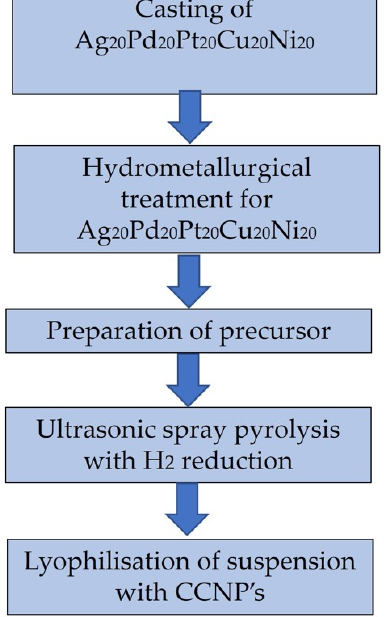
Figure 1. Proposed methodology of procedures for the synthesis of CCNPs.